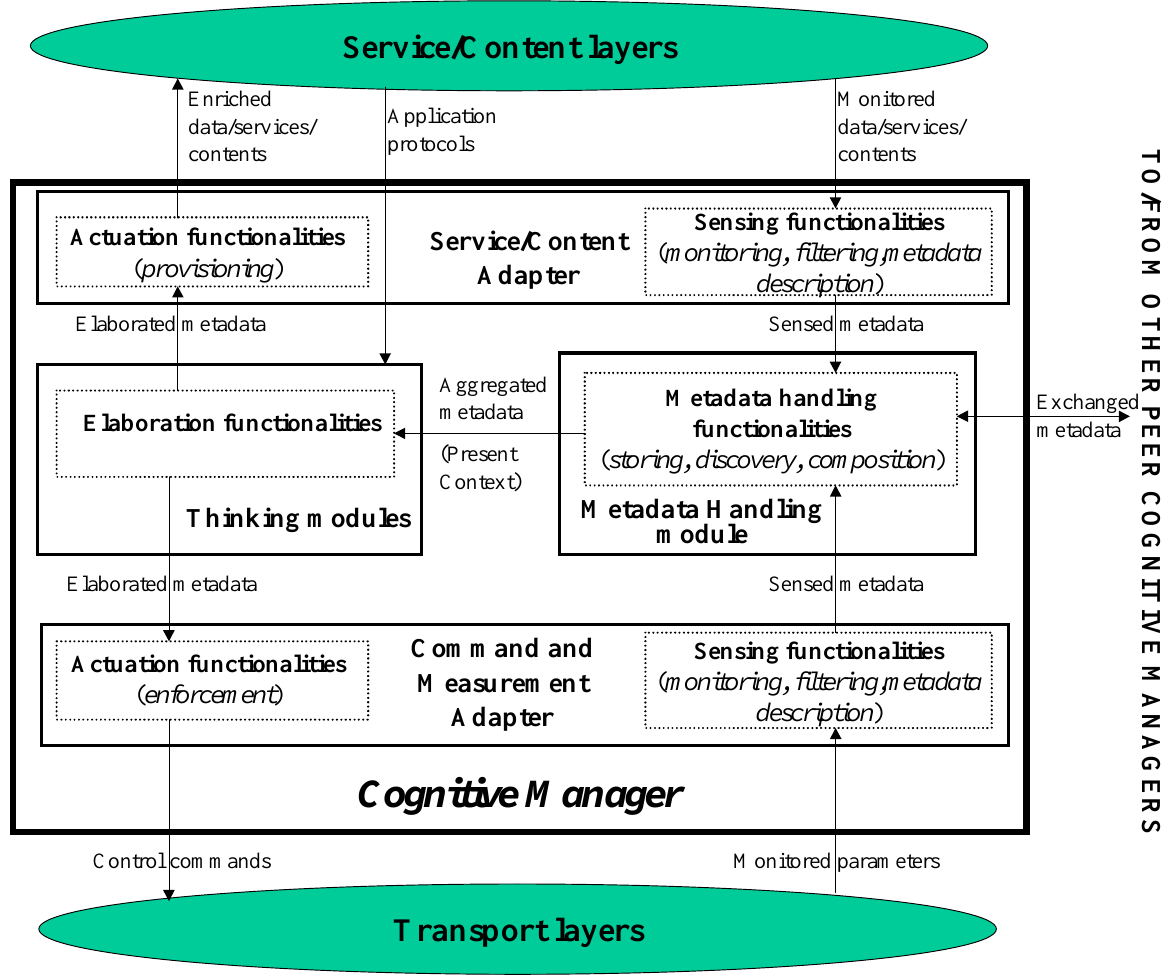
Figure 2. Cognitive Manager